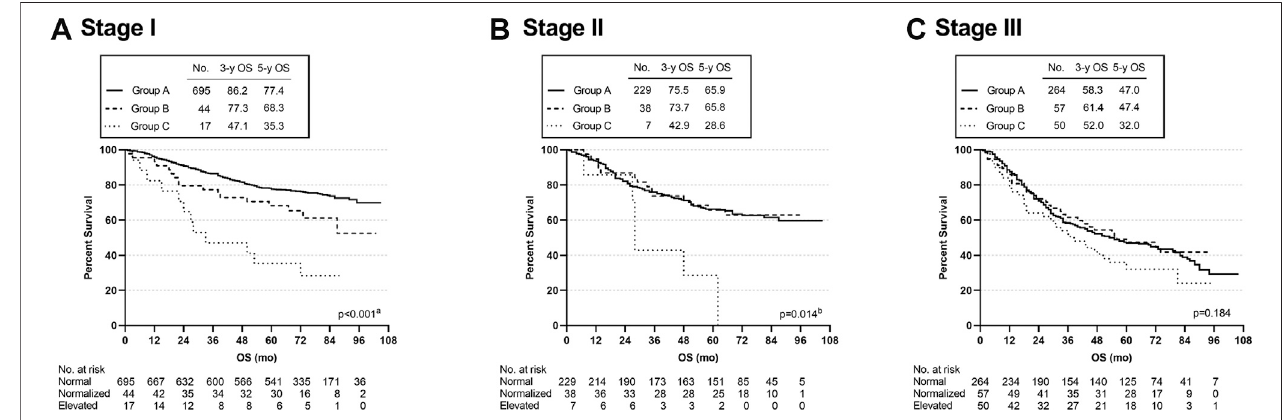
FIGURE3| Overallsurvivalcurvesofpatientswithdifferentsubgroups,groupedbyTNMdiseasestage. a GroupAvs.GroupC, p < 0.001;GroupAvs.GroupB, p (cid:1) 0.039; Group B vs. Group C, p (cid:1) 0.018. b Group A vs. Group C, p (cid:1) 0.004; Group B vs. Group C, p (cid:1)